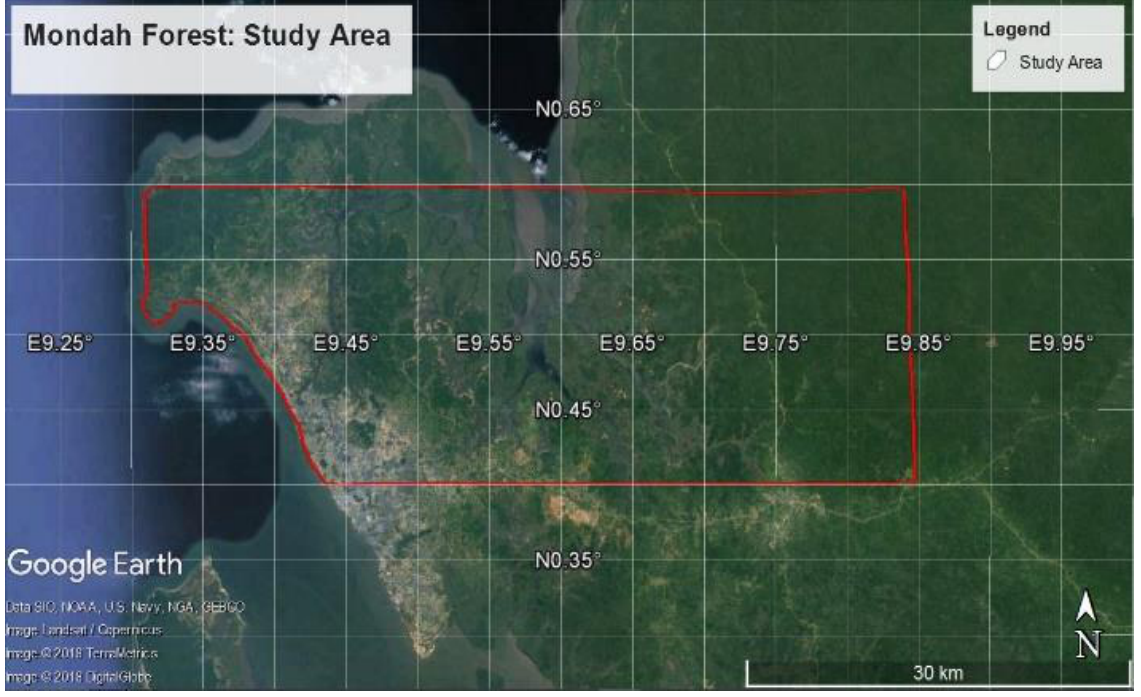
Figure 1. Study Area